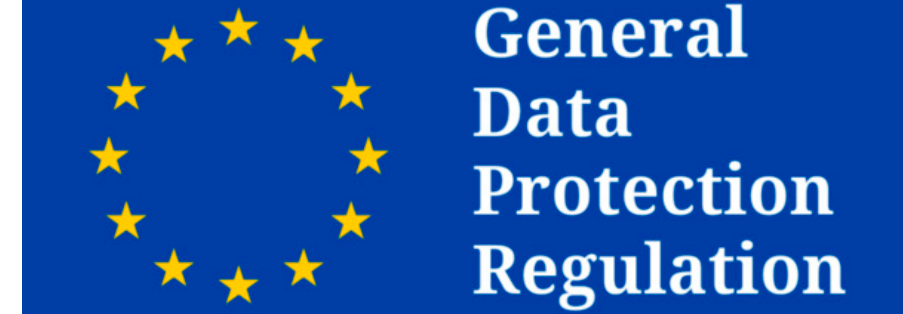
Figure 3. General Data Protection Regulations (GDPR) for raw data (source, gdpr.kisa.or.kr/index.do) .